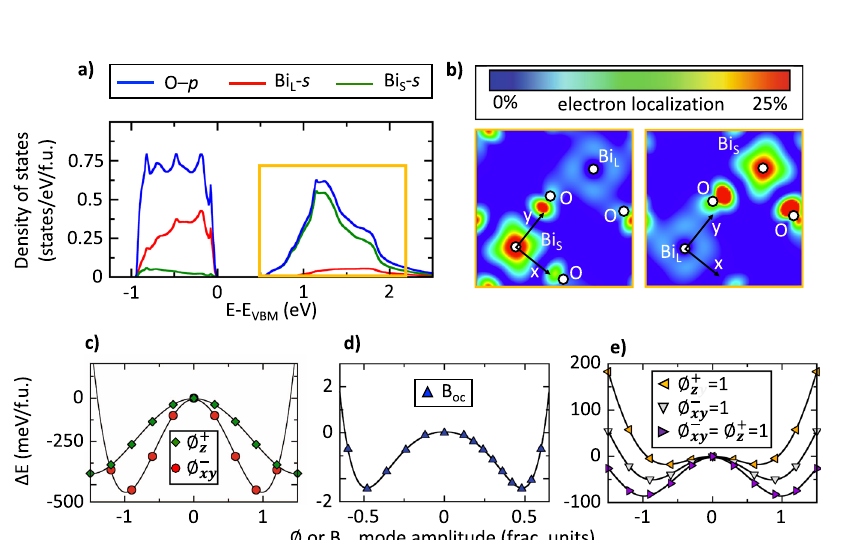
Fig. 2 Ground state properties of SrBiO 3 . a Density of states (in states/eV/f.u) projected on Bi S -s (in green), Bi L -s (in red), and O-p (in blue) states. b Partial charge density map associated with the states at the bottom of the conduction band indicated by the orange area in panel a. c – e Potential energy surface starting from a perfectly undistorted Pm-3m cubic cell associated with the anti-phase a - a - c 0 ; (cid:2) a 0 a 0 c + ; þ octahedral rotations ( d ), breathing mode B oc ( e ) and breathing mode B oc at fi xed ; þ z lattice parameter of the cubic cell is chosen so that its volume is identical to the ground state volume. An amplitude of 1 corresponds to the amplitude appearing in the DFT relaxed ground state